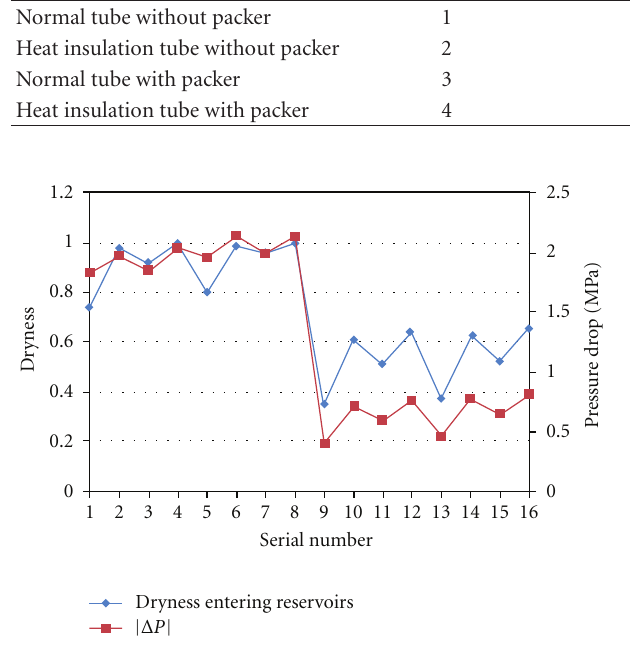
Figure 11: Dryness and pressure drop of injected steam in the 16